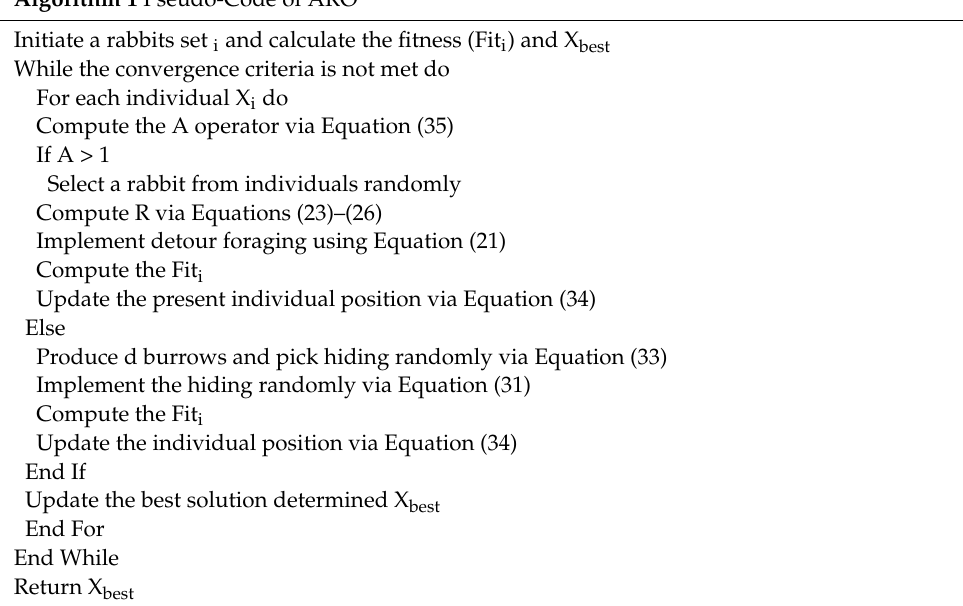
Algorithm 1 Pseudo-Code of